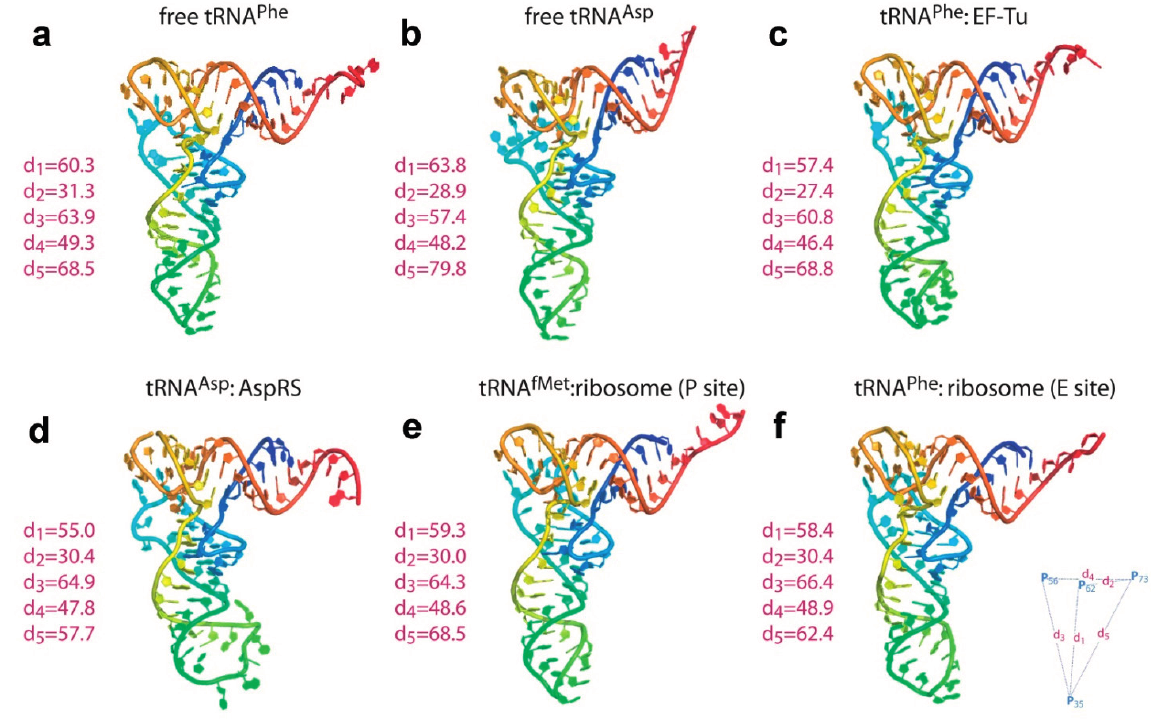
Figure 2. A gallery of tRNA atomic structures, isolated or in complex with EF-Tu, aminoacyl tRNA synthetase (RS) or the ribosome. ( a ) PDB 4TRA [8]; ( b ) PDB 2TRA [8]. ( c ) PDB 1TTT [11]; ( d ) PDB 1ASY [12]; ( e , f ) PDB 4V51 [13]. The different regions of the tertiary structure of tRNA are color-coded. Variability is mainly manifested on the distal parts ( i.e. , ASL and CCA end), as well as in the relative angle between the anticodon and acceptor stems. Plasticity is also readily observed in the D- and T-loop regions. Measured distances between some phosphorus atoms (in Å) are shown on the left side of the